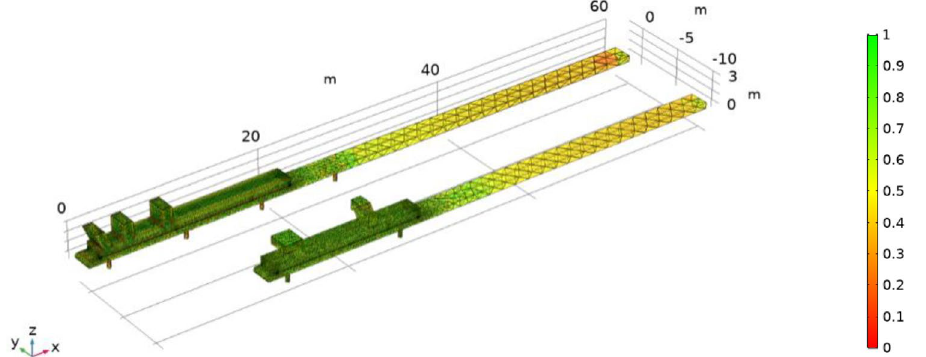
Figure 3. 26 Double tape mesh